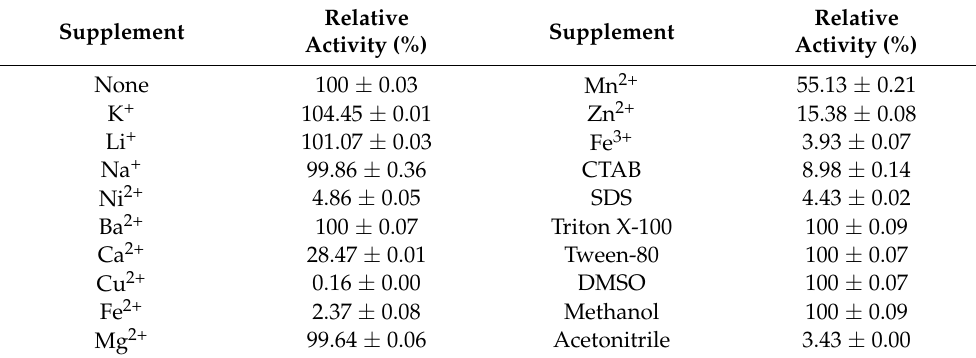
Table 1. Effects of metal ions and chemical reagents on the activity of α -galactosidase. Relative Relative Supplement Supplement Activity (%) Activity (%) None 100 ± 0.03 Mn 2+ 55.13 ± 0.21 K + 104.45 ± 0.01 Zn 2+ 15.38 ± 0.08 Li + 101.07 ± 0.03 Fe 3+ 3.93 ± 0.07 Na + 99.86 ± 0.36 CTAB 8.98 ± 0.14 Ni 2+ 4.86 ± 0.05 28.47 ± 0.01 Tween-80 100 ± 0.07 Cu 2+ Methanol 100 ± 0.09 Mg 2+ 99.64 ± 0.06 Acetonitrile 3.43 ±